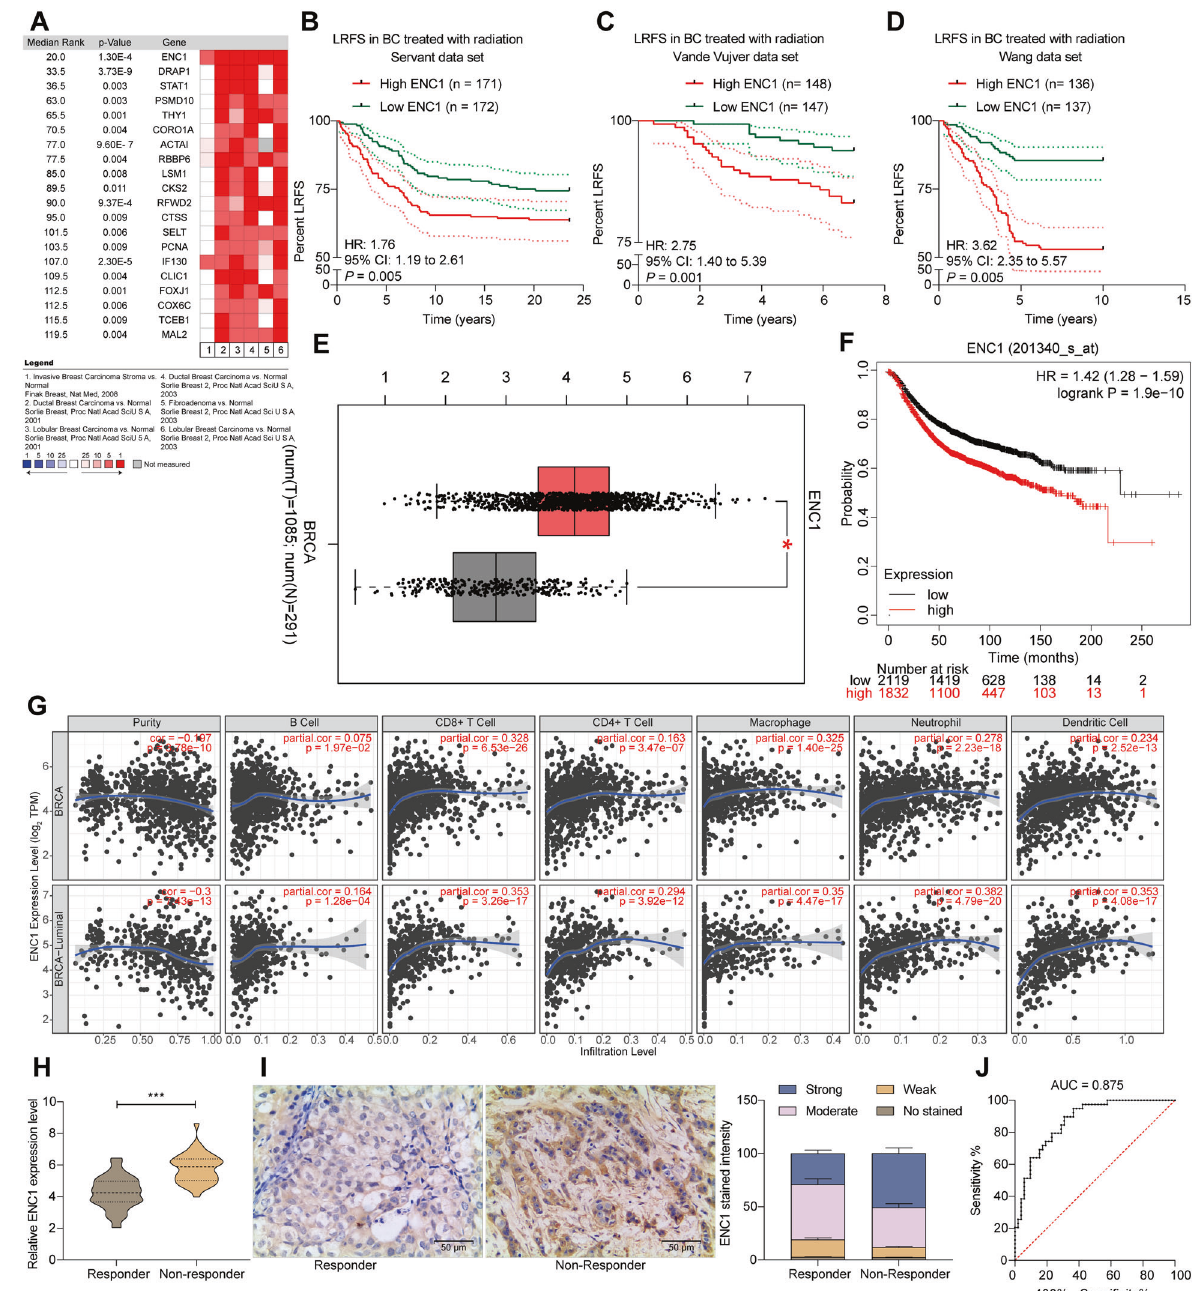
Sorlie Breast 2 datasets. B – D Correlation between ENC1 expression and LRFS in BC patients in Servant ( B ), Vande Vijver ( C ), and Wang ( D ) datasets. E ENC1 expression in the TCGA-BRCA dataset. F Analysis of the association between ENC1 expression and survival of patients in TCGA-BRCA dataset. G Analysis of the connection between ENC1 expression and the in fi ltration of immune cells in BC patients. H , I RT-qPCR ( H ) and immunohistochemical detection ( I ) of ENC1 expression in 39 non-responder and 52 responder BC patients. J ROC curve analysis of the predictive ef fi cacy of ENC1 expression and sensitivity to radiotherapy in BC patients. All the data are expressed as the mean ± SD. Unpaired t - test (panel H ) or two-way ANOVA with Tukey ’ s multiple comparison test (panel I ) were utilized to detect signi fi cant differences between data, *** p <